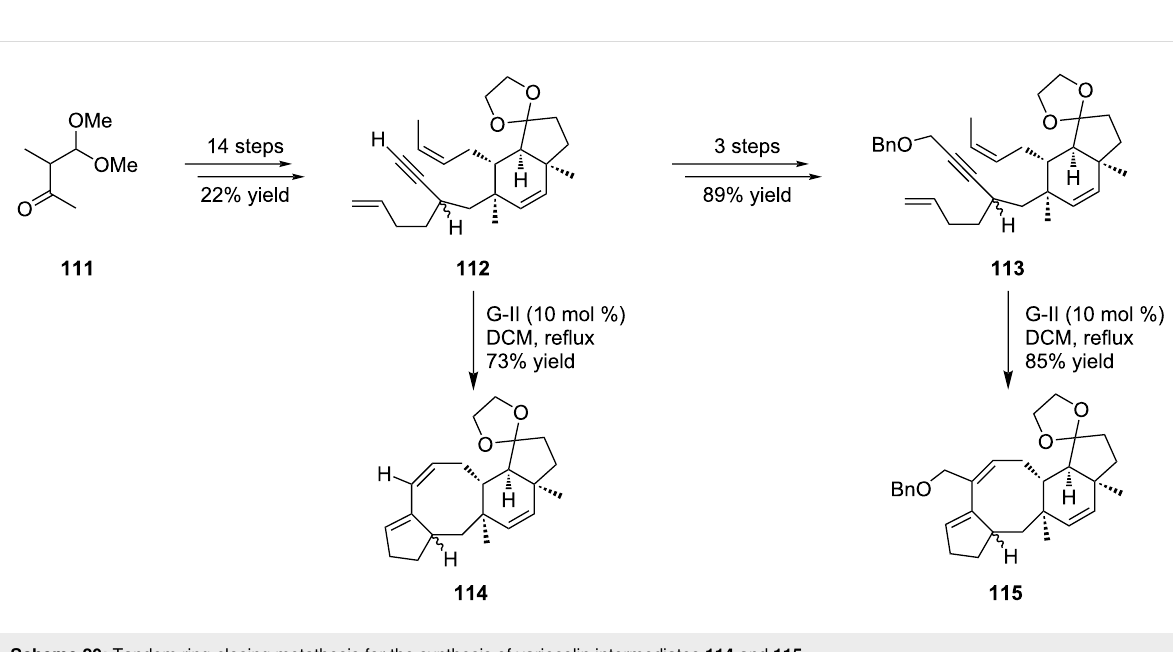
Scheme 20: Tandem ring-closing metathesis for the synthesis of variecolin intermediates 114 and 115 .